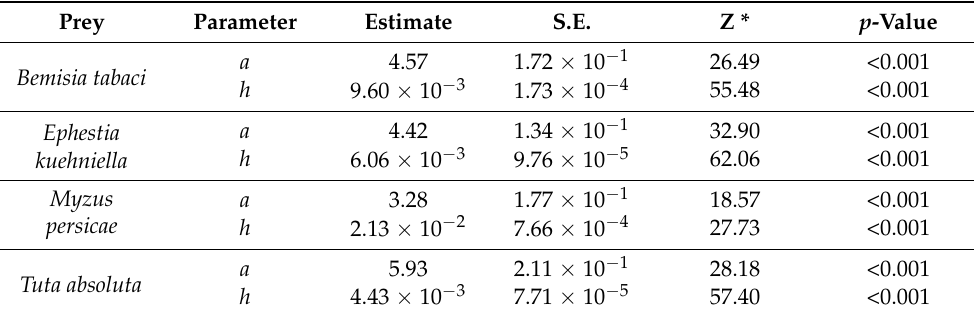
Table 4. Parameters a (attack rate) and h (handling time), standard error (S.E.) estimated by maximum likelihood using Rogers’ random predator equation (Type II functional response) for Dicyphus cerastii females feeding on different prey ( Bemisia tabaci 4th instar nymphs, Ephestia kuehniella eggs, Myzus persicae 1st instar nymphs or Tuta absoluta